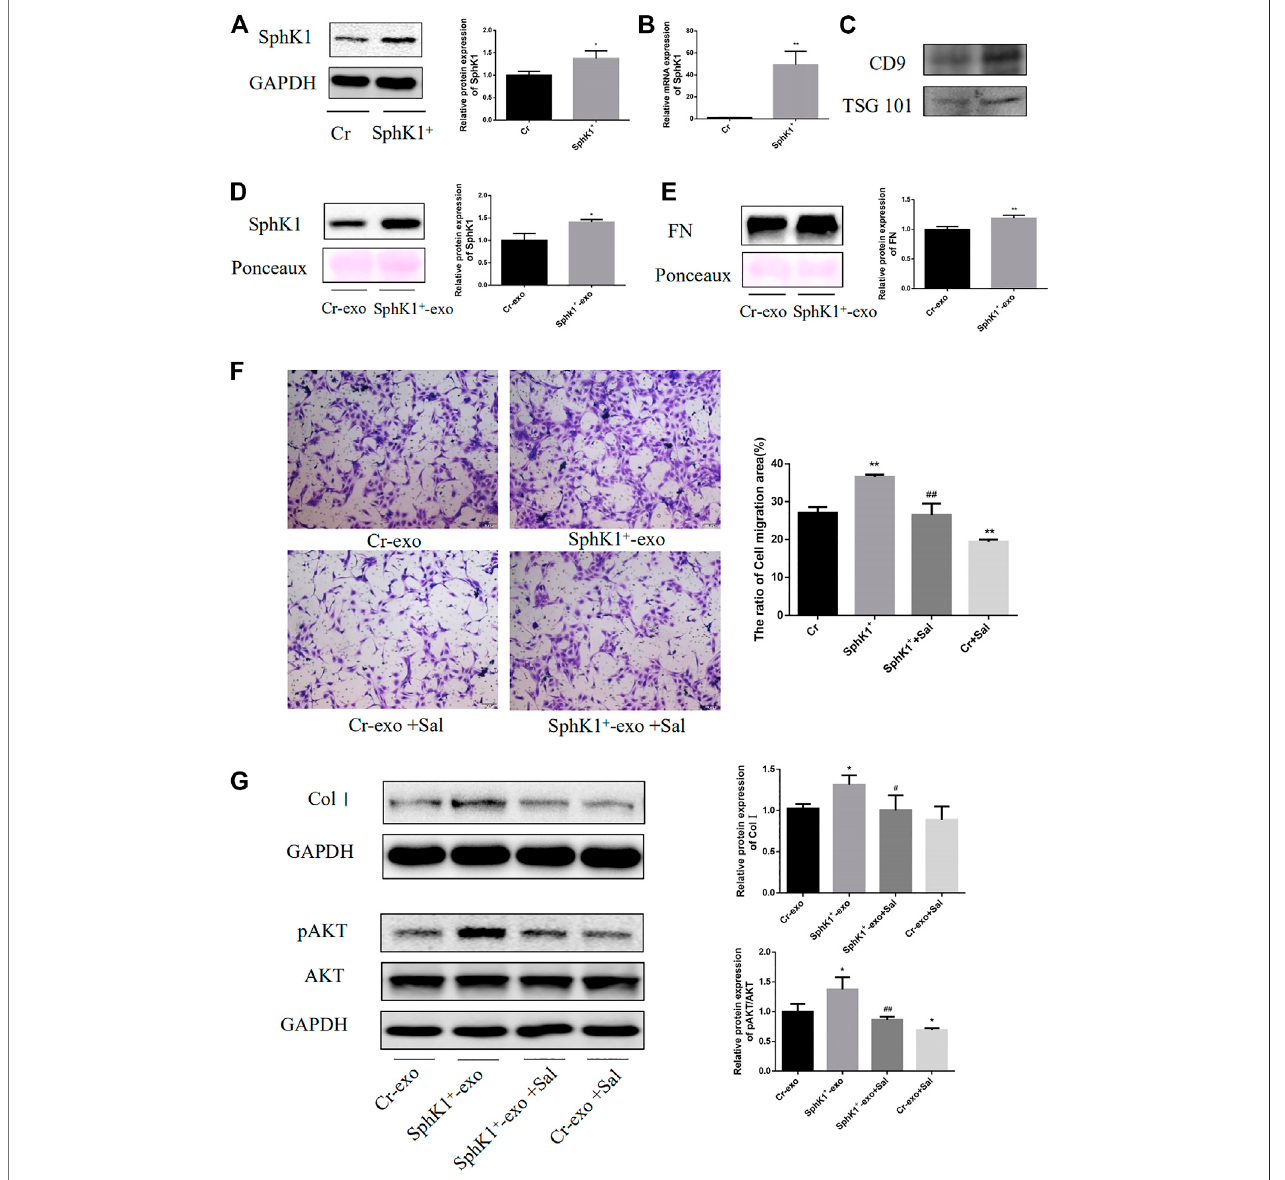
FIGURE 6 | Effects of Sal on exosomal SphK1-induced LX-2 migration and activation. (A) : Expression of SphK1 in transfected cells was detected by WB. (B) : Expression of SphK1 in transfected cells was detected by PCR. (C) : Expression of TSG101 and CD9 in exosomes from culture mediums. (D,E) : Expression of SphK1 and FN in exosomes from culture mediums of transfected cells. ( n (cid:1) 3, ** p < 0.01, vs Cr-exo.) (F) : Sal inhibited exosomal SphK1-induced LX-2 migration and activation. (G) : Sal inhibited exosomal SphK1-induced AKT phosphorylation in LX-2. ( n (cid:1) 3, * p < 0.05, ** p < 0.01, vs. Cr-exo; # p < 0.05, ## p < 0.01, vs. SphK1 + -exo.).